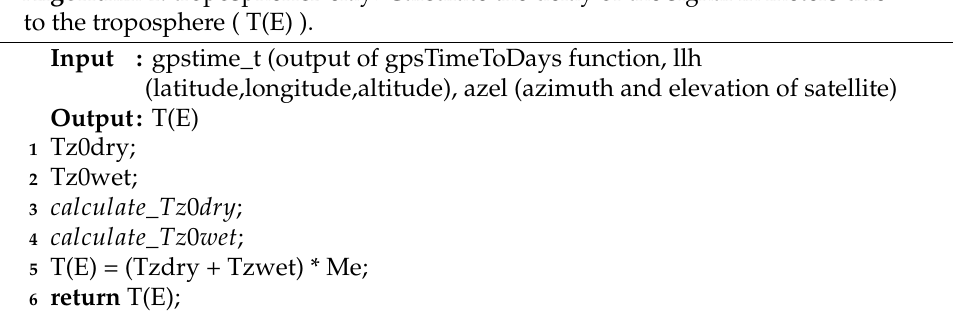
Algorithm 1: troposphericDelay: Calculate the delay of the signal in meters due to the troposphere ( T(E) ).